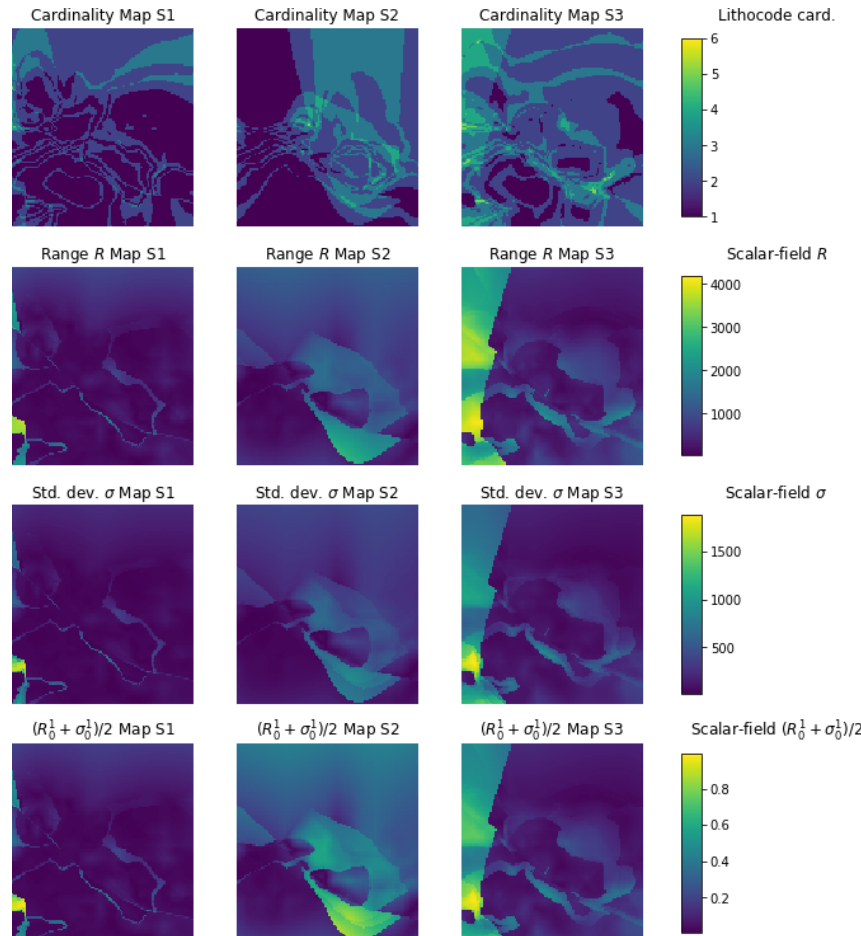
Figure 6. Horizontal sections of cardinality voxets for a categorical property field (first row) or similar indicators for a continuous property field (second–fourth row); the first row shows the cardinality over the ensemble of lithocode voxets, the second row displays the (max-min range) over the ensemble of scalar field voxets, the third row presents the standard deviation over the ensemble of scalar field voxets, the fourth row displays the averaged normalised range and standard deviation over the ensemble of scalar field voxets; the left column refers to scenario 1, the middle column to scenario 2 and the right column to scenario